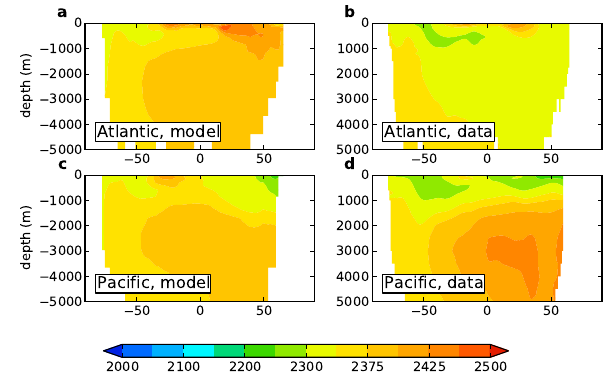
Figure 15. Zonal average of the dissolved inorganic carbon (DIC) distribution in the ocean (µmolkg − 1 ). Data from GLODAP (Key et al., 2004).